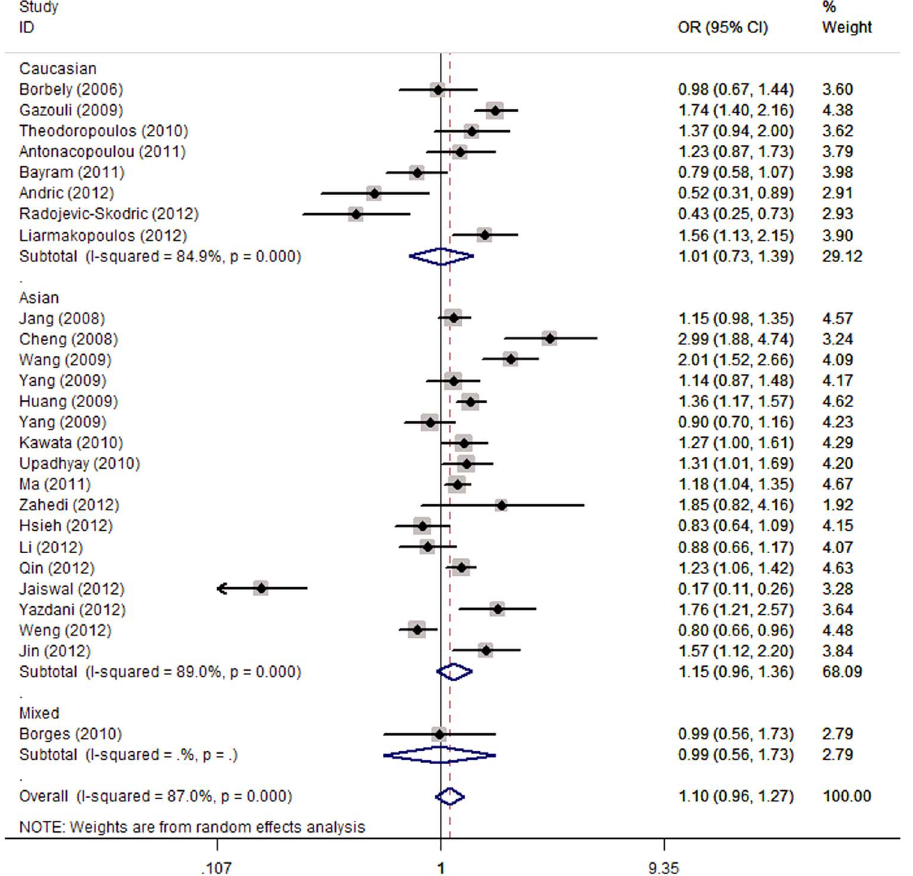
Figure 3. Forest plot of tumor risk associated with the survivin rs9904341 under the allele contrast. doi:10.1371/journal.pone.0074778.g003 PLOS ONE |